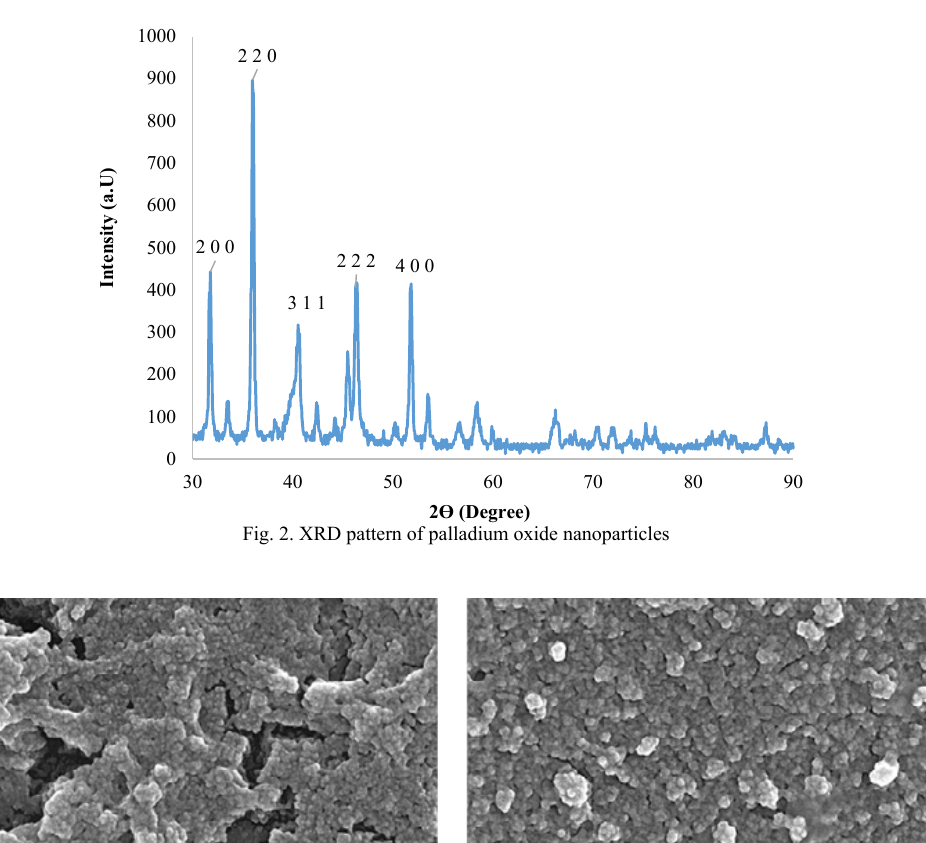
Fig.2 XRD pattern of palladium oxide nanoparticles